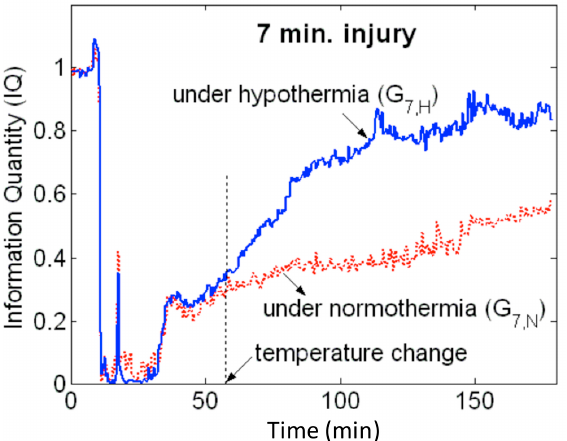
Figure 2. Information Quantity (IQ) temporal evolution following a 7-min CA model in rats. The blue curve represents the IQ profile when TH was applied at the point marked as “temperature change.” The red curve represents the IQ profile when normothermia was maintained. At the onset of injury, there is a rapid drop of IQ values, but after the temperature change, the blue curve shows an increasing trend of higher IQ values compared to the red curve, displaying the protective effect of TH compared to normothermia.